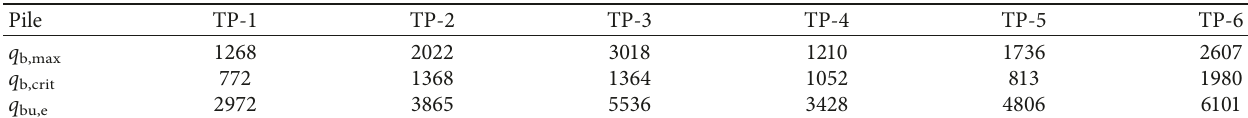
23.0 (cid:31) Table 5: Unit base resistance (kPa).